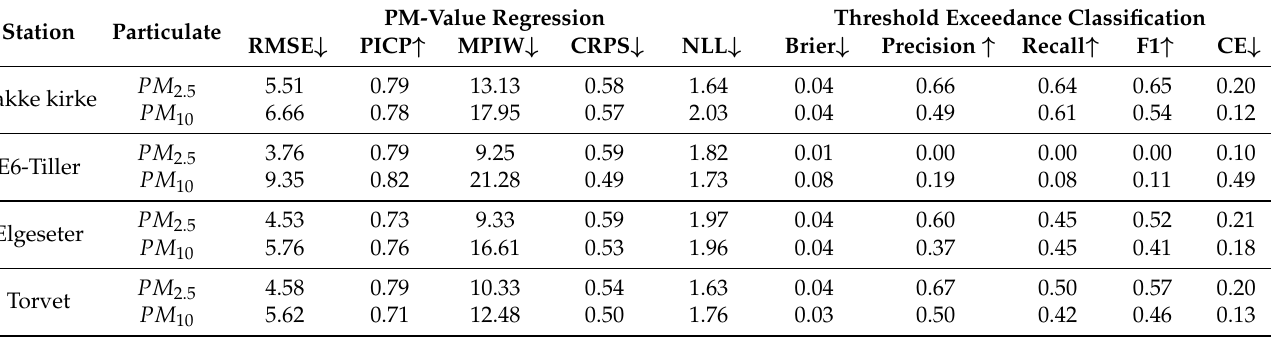
Figure 22. Probabilistic threshold exceedance classification using a SWAG model. Table 7. Summary of performance results when using a SWAG model with adversarial